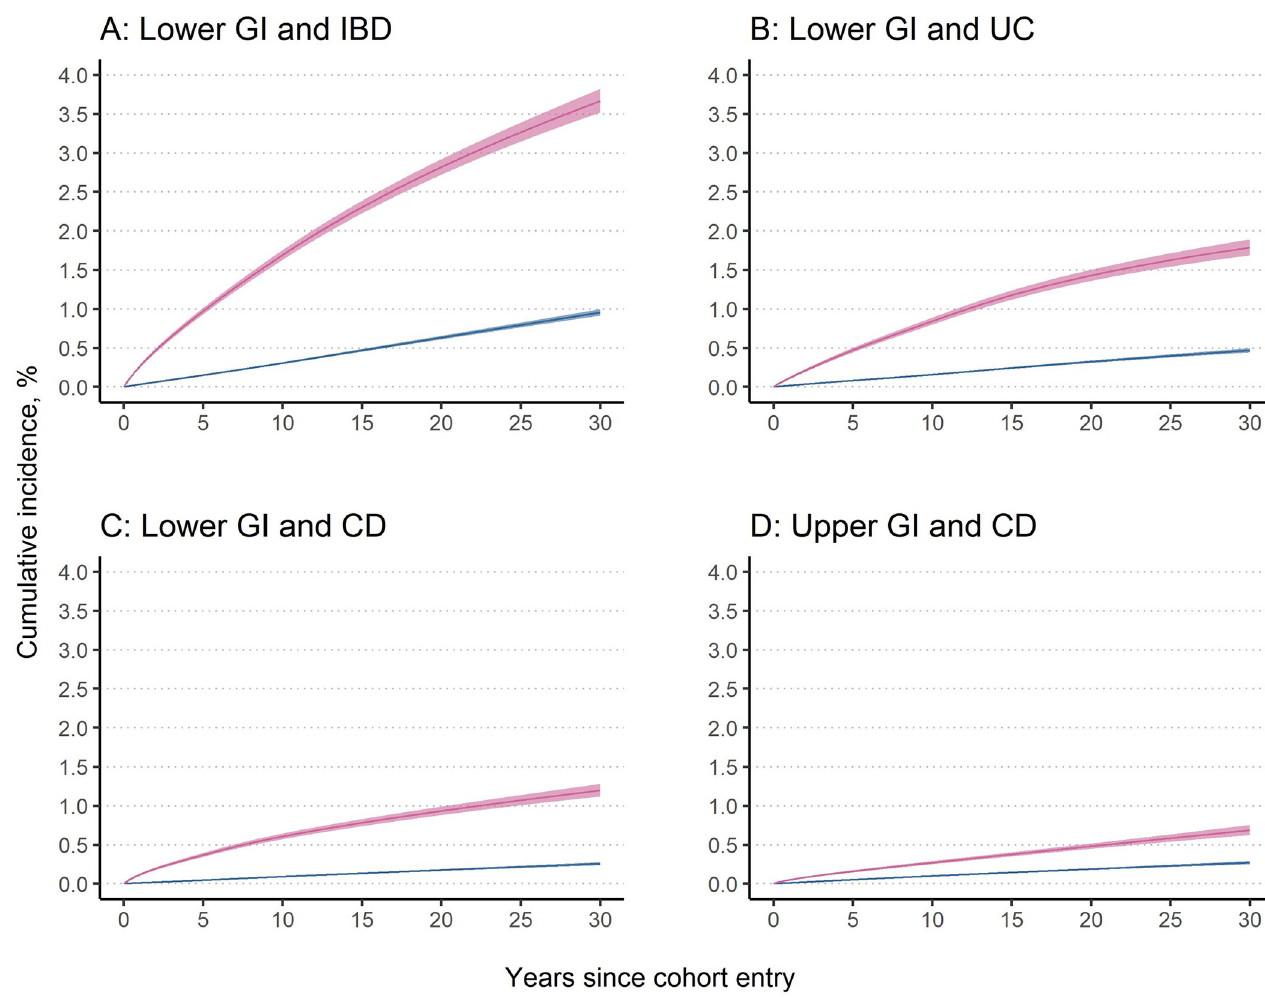
Fig 2. Standardized cumulative incidence and 95% CI of IBD in individuals with a GI biopsy result of normal mucosa (pink) and their matched population references (blue). The cumulative incidence was estimated from the flexible parametric survival model conditioned on matching set (birth year, sex, county of residence, and calendar period) and further adjusted for country of birth, educational attainment, number of healthcare visits, Charlson comorbidity index, and history of GI diseases. Date of cohort entry was defined as 6 months after the index date. CD, Crohn’s disease; CI, confidence interval; GI, gastrointestinal; IBD, inflammatory bowel disease; UC, ulcerative colitis.